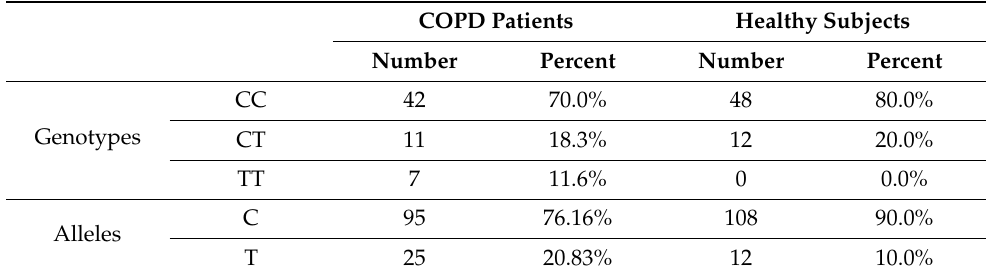
Table 3. Distribution of genotypes and alleles in the COPD group and control group.